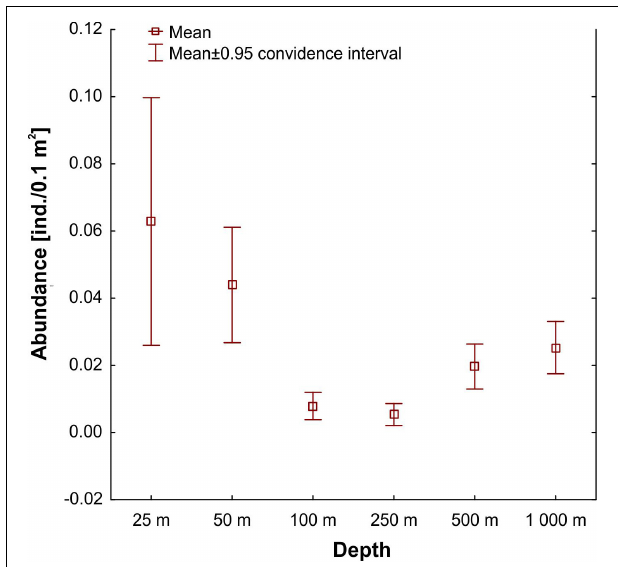
FIGURE 3 | Mean abundance at each sampled depth.